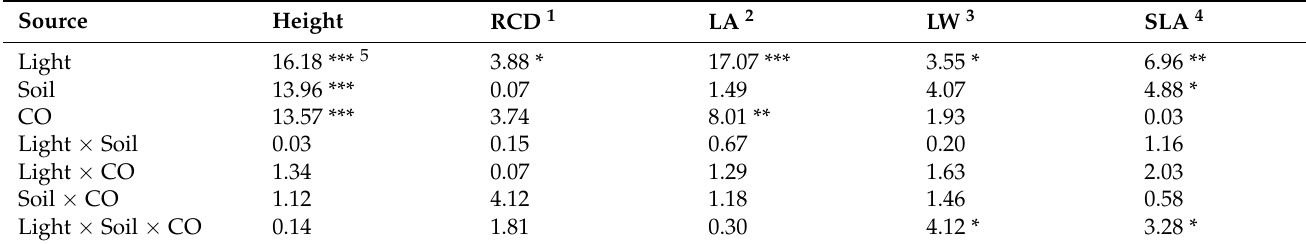
Table 3. F values from analysis of variance (ANOVA) of combined factors of lighting spectra (Light), soil amendment (Soil), and chitosan oligosaccharide (CO) addition on growth, leaf morphology,